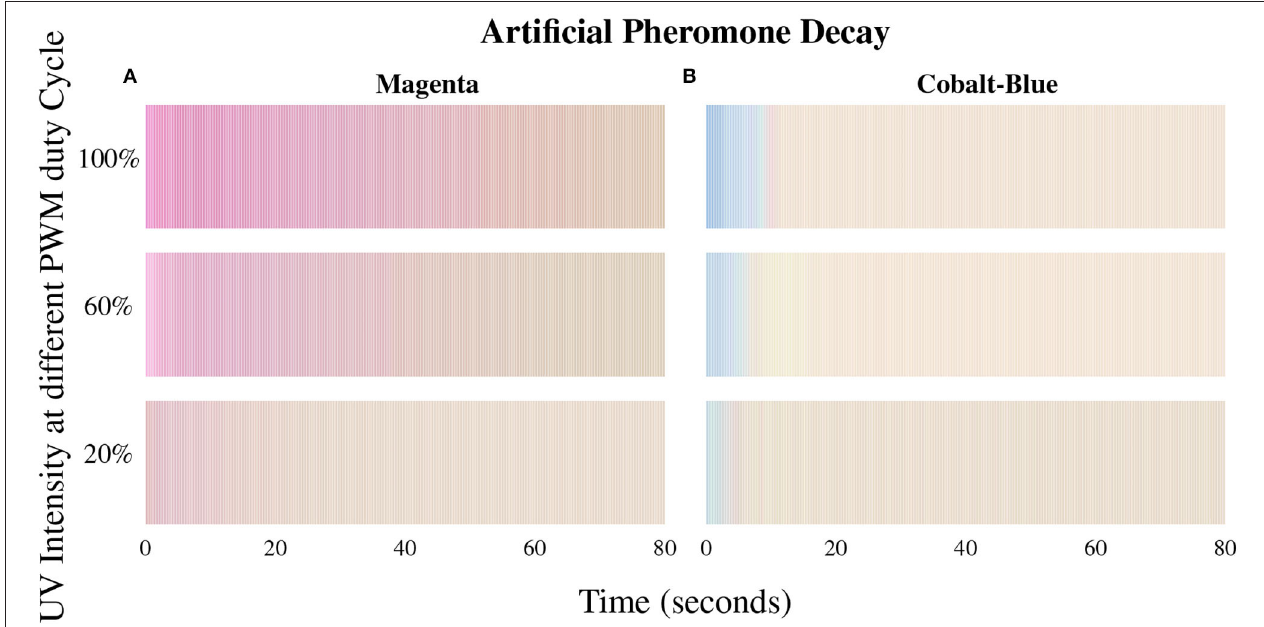
FIGURE 1 | Time taken by the photochromic substances (A) magenta and (B) cobalt-blue to switch back to white color after a UV light source is removed. The substances are tested under three different intensities of UV light. The intensity of UV light is controlled by varying the pulse-width-modulation (PWM) duty cycle of UV LEDs.